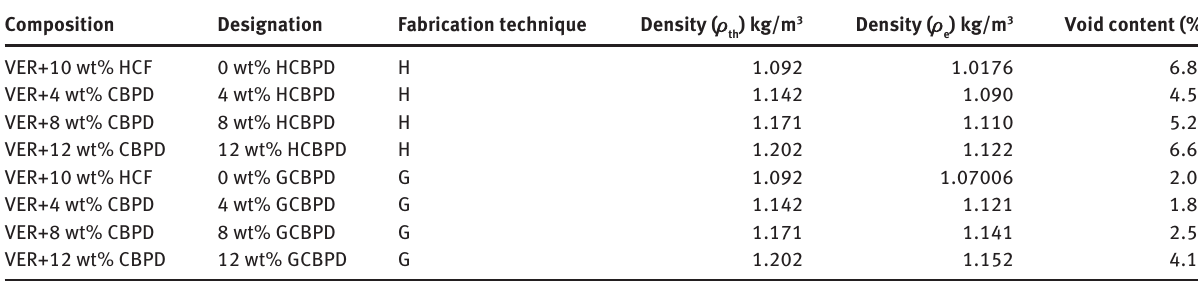
Table 2 Effect of void fraction on filler loading of the